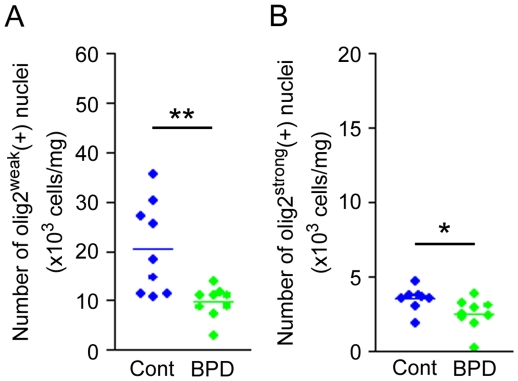
Densities of olig2weak(+) and olig2strong(+) nuclei in 1 mg of gray matter tissue from BPD FPC. (A) olig2weak(+), and (B) olig2strong(+) nuclei.*P<0.05 by unpaired t-test.